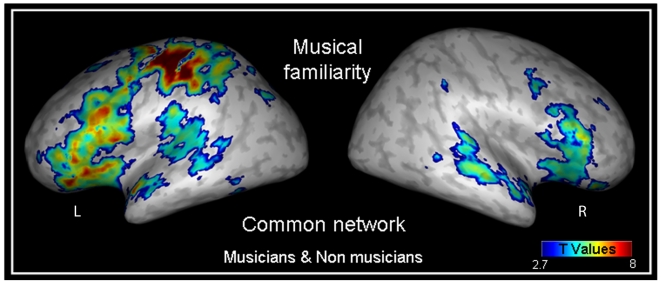
Common network between groups for the musical familiarity task.This network was composed of a left extensive cluster including motor, and inferior frontal areas, the bilateral superior temporal gyri, the right cerebellum and the inferior frontal gyrus and the left inferior parietal gyrus (see also Table 2). Contrasts are displayed at p<0.005 (uncorrected) and superimposed onto an inflated reconstruction of an MNI template brain using Anatomist software (www.brainvisa.info). Abbreviations: L = left hemisphere, R = right hemisphere.